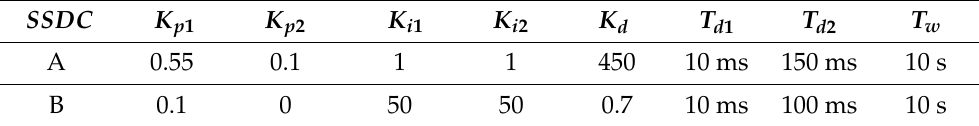
Figure 12. Eigenvalues for various grid strengths with proposed ( a ) SSDC-A ( b ) SSDC-B. Table 6. SVC control gains and SSDC parameters considered in Section